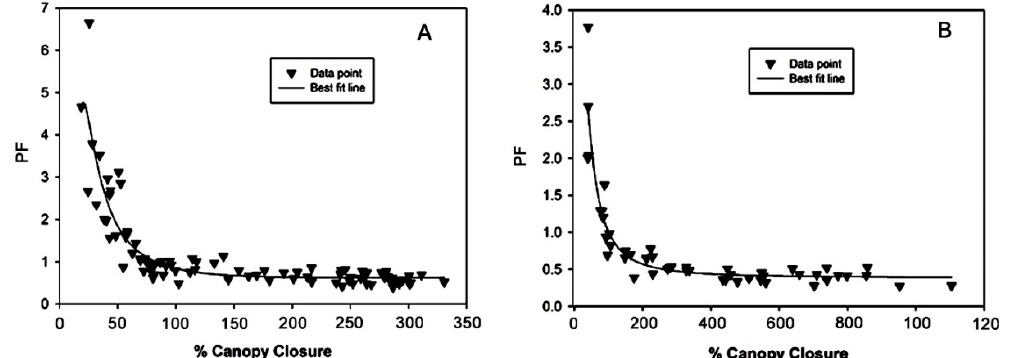
Figure 3. Inverse polynomial relationship between % Canopy Closure (%CC) and plant factor (PF) or the water need index (WNI) for Davallia bullata ( A ) and Nephrolipis exaltata ( B ). Data points are four plant replicates, and equation for the best fit line presents in Table 2.